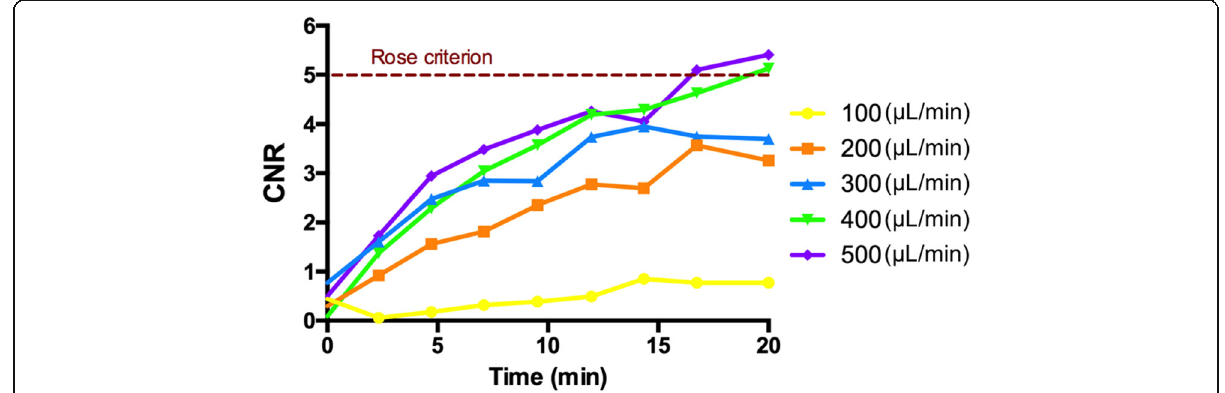
Fig. 1 Contrast-to-noise ratio quantification for several infusion rates. Tested contrast injection rates from 100 to 500 μ L/min (yellow), with an overall administration time of 20 min. The red dashed line defines the applied cutoff criterion to determine the optimal infusion rate. CNR Contrast-to-noise